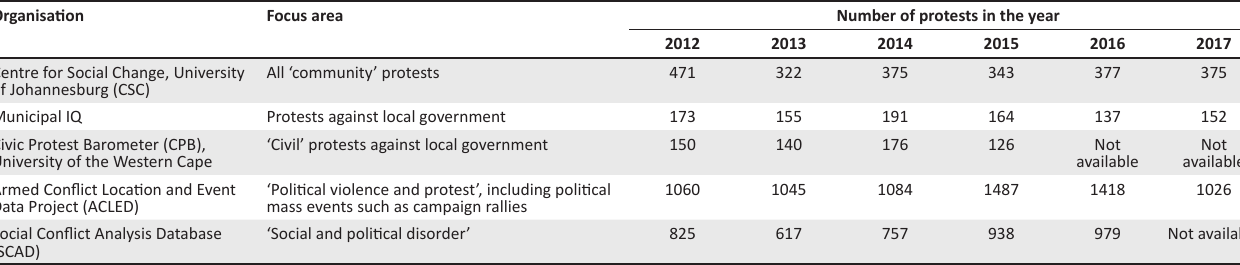
TABLE 3: Protest numbers by various organisations, 2012–2017.